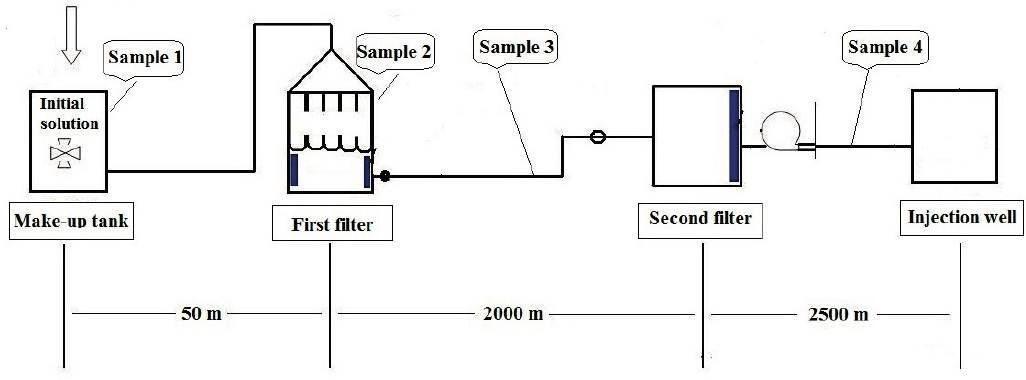
Figure 1. Schematic diagram showing the water injection system and the sampling sites.